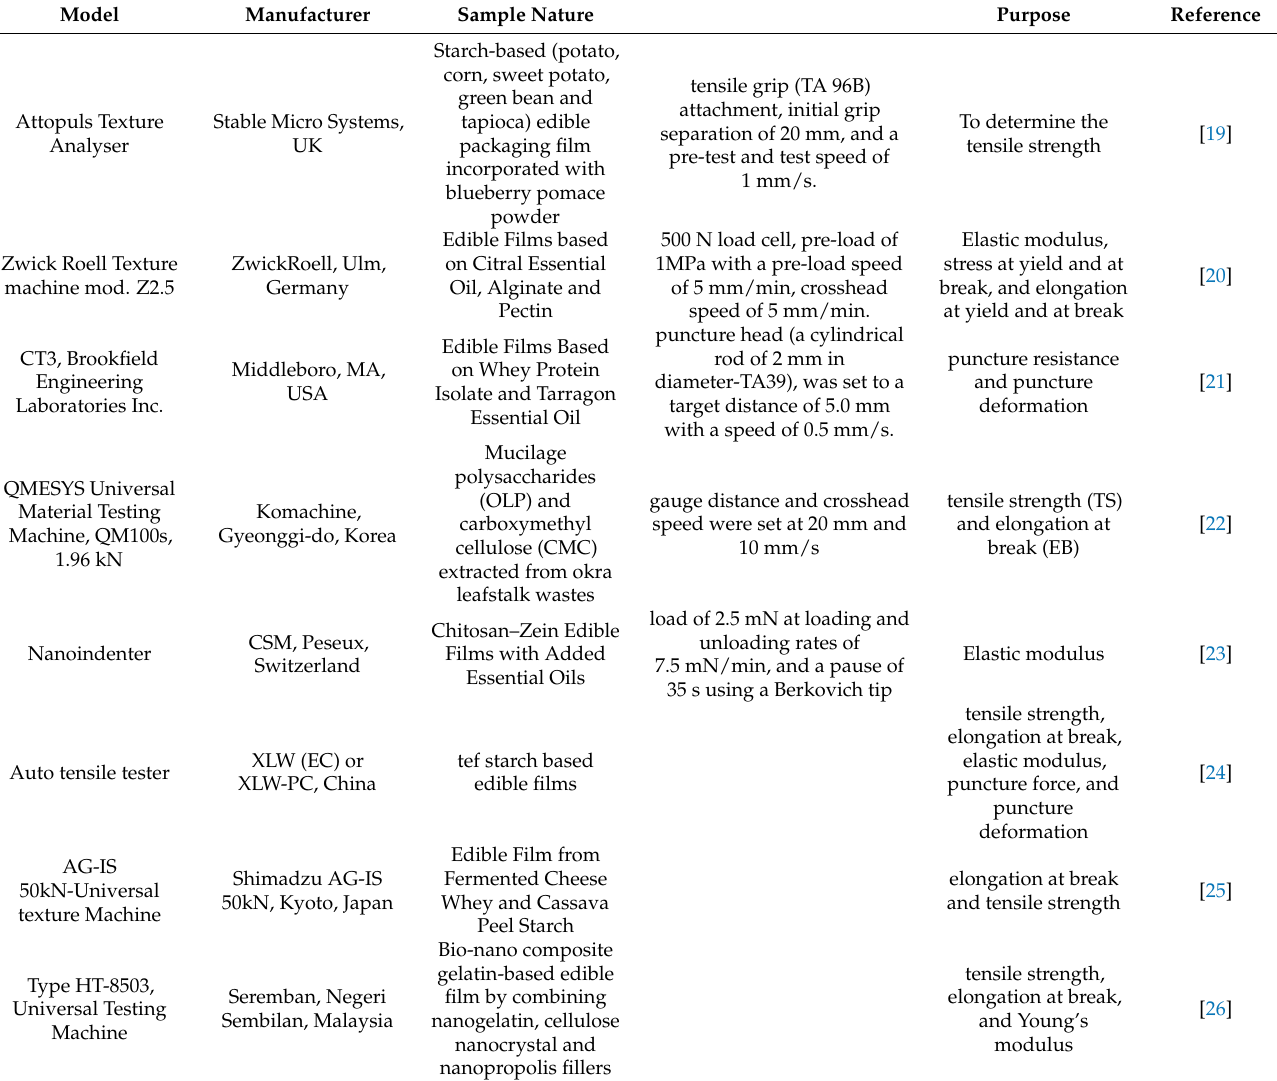
Table 1. Instruments to assess the mechanical strength of the food packaging